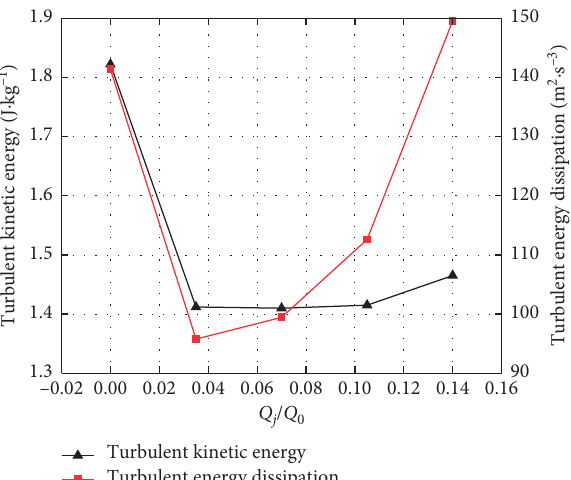
Figure 15: The change of turbulent kinetic energy and turbulent energy dissipation of the nozzle under different jet flow rates.